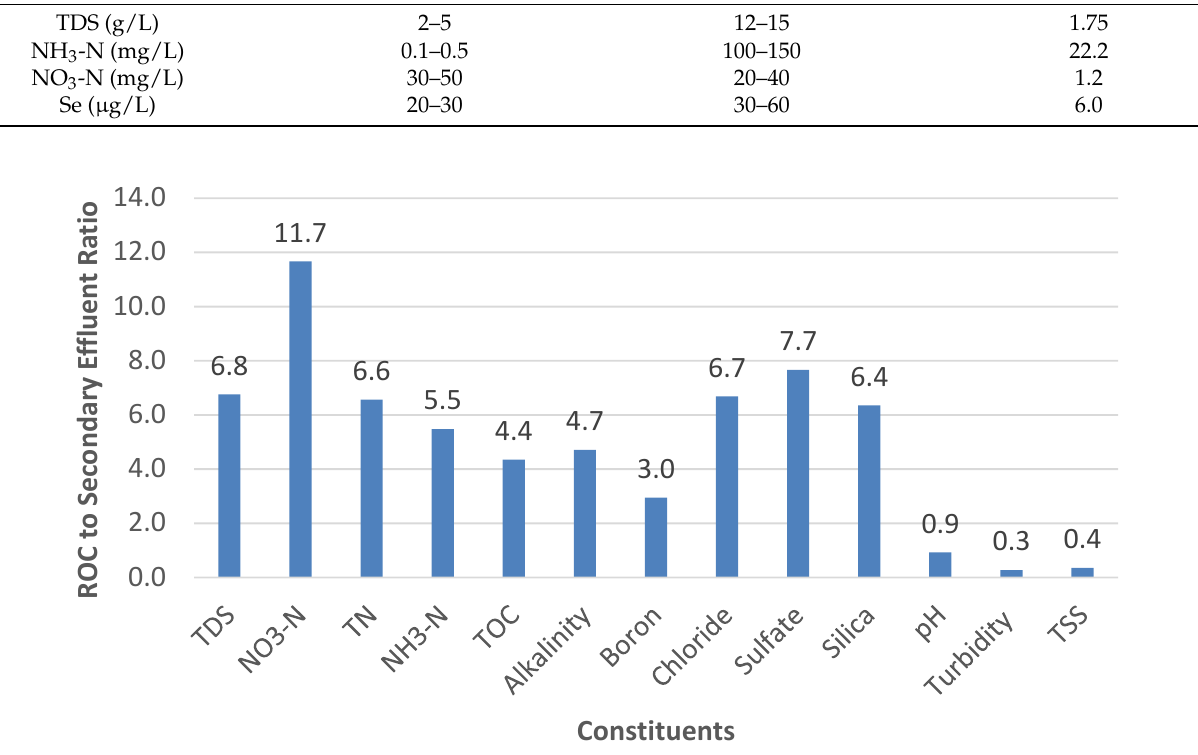
Figure 12. Constituents in the ROC to the WWTP secondary effluent ratio (number of samples, 6).